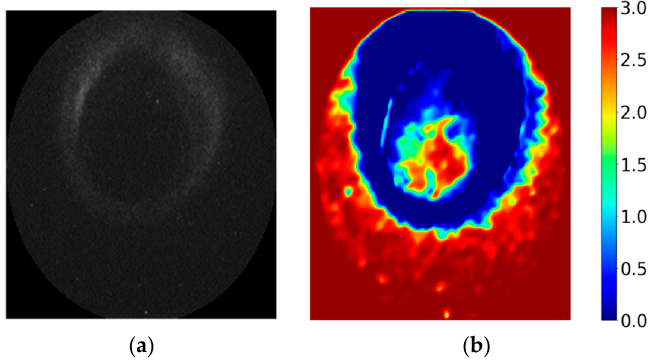
Figure 7. Auroral image and the corresponding time step map. ( a ) Auroral oval image. ( b ) The corresponding time step map.